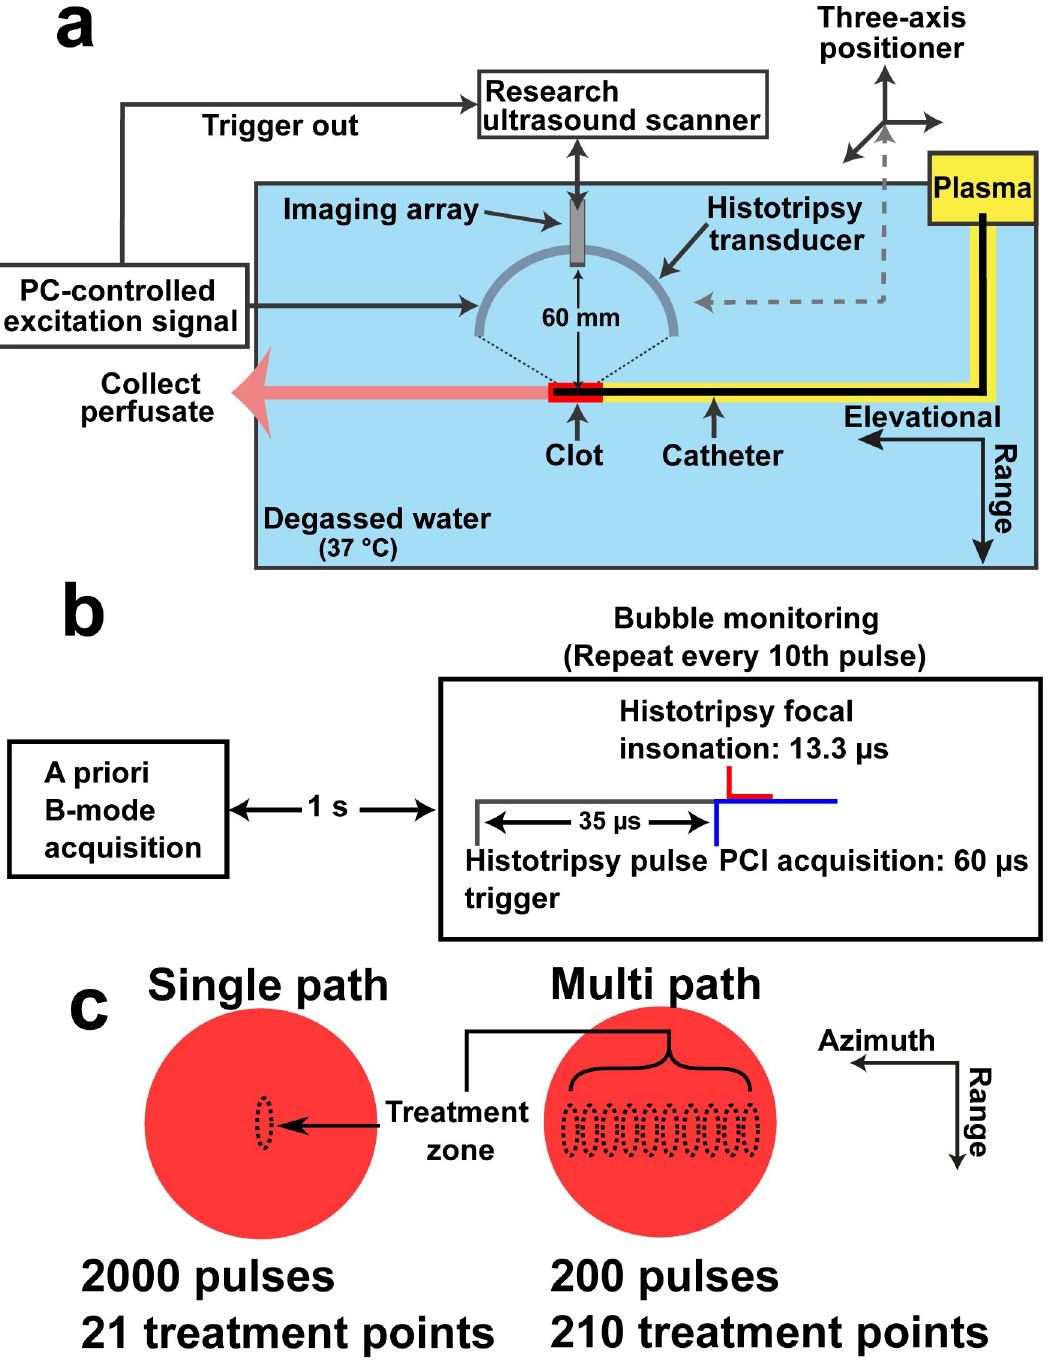
Fig 1. Experimental setup. (a) Overview of flow channel system. Plasma flowed from right to left in the figure. Bubble activity was initiated in the clot with a focused histotripsy source. Lytic was infused directly within the clot via the multi-side port catheter. The ‘Elevational’ and ‘Range’ dimensions correspond to the imaging plane for the diagnostic imaging array. The ‘Azimuthal’ dimension of the imaging plane (i.e. along the elements of the array) is into the page. (b) Timing diagram for the acquisition of acoustic emissions generated during histotripsy insonation. Passive acquisition of acoustic emissions was initiated 5 μ s before the histotripsy pulse reached the focus. (c) Cross sectional view of clot with labeled insonation locations for single and multi-path histotripsy exposure schemes. For the single-path exposure scheme, bubble activity was generated at 21 discrete locations along the length of the clot (i.e. 21 different cross sections of the clot), and the focus targeted the center of the clot cross section (dashed line). The multi-path scheme scanned the histotripsy source along the length of the clot ten times, with each scan displaced by 0.25 mm laterally to